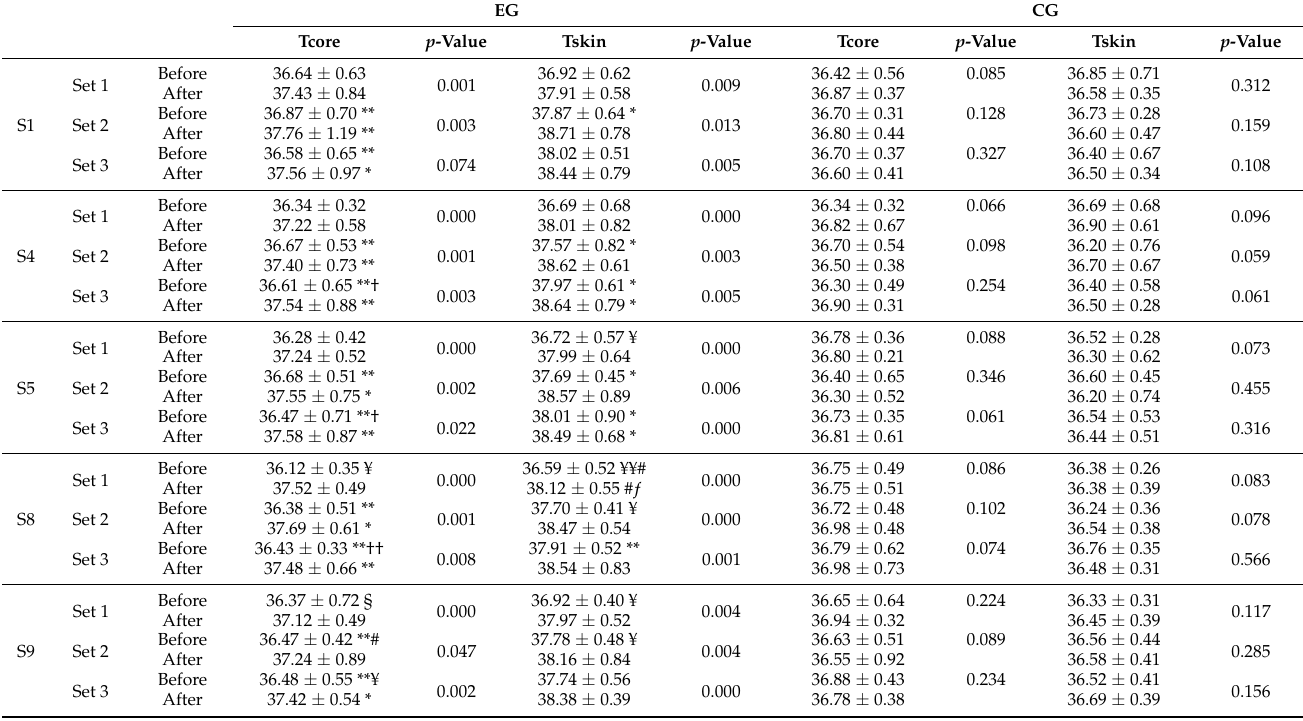
Table 2. Tcore and Tskin during S1, S4, S5, S8, and S9 of this